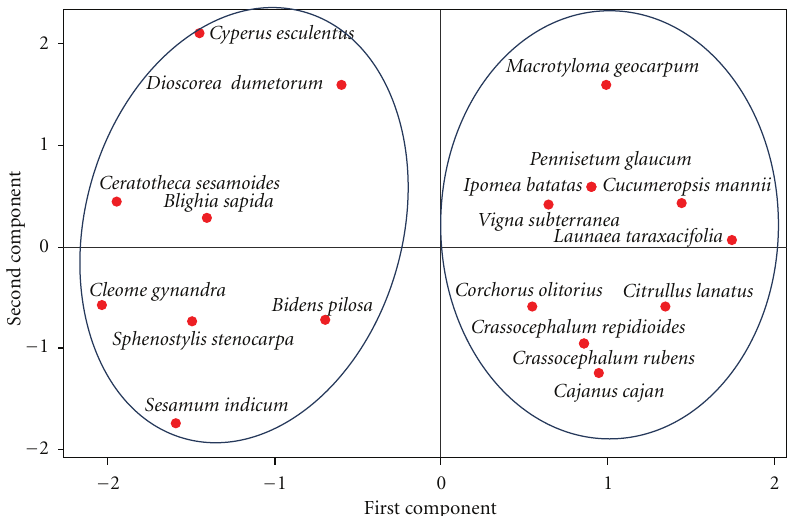
Figure 5: Principal component analysis showing di ff erent groups within the priority NUCS.